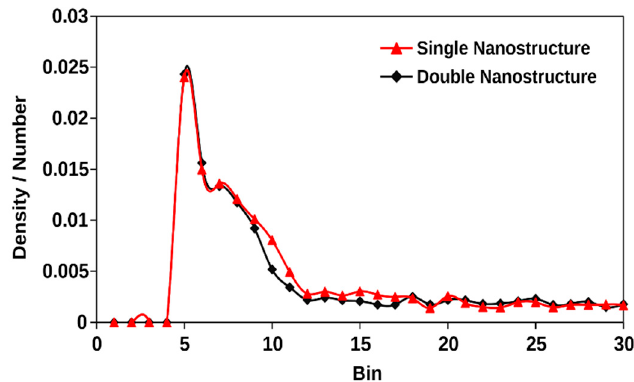
Figure 23. Comparison of density profile of argon at 4 ns for one nanostructure and two nanostructures.